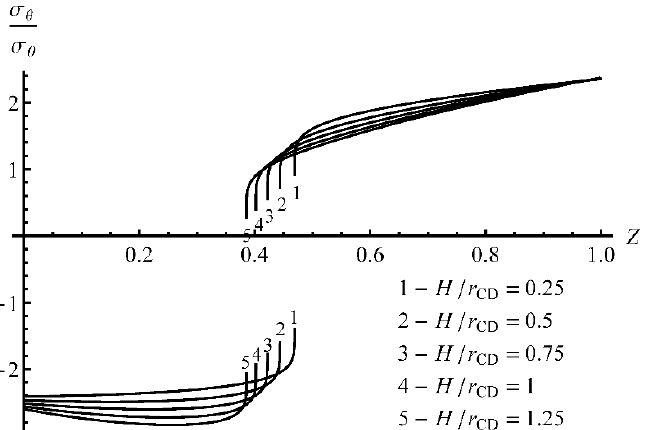
Figure 4. Through ‐ thickness distribution of the radial stress at γ = 1 and several process stages.